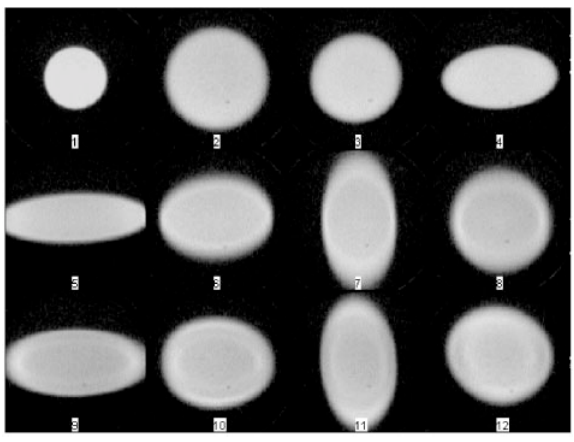
FIG. 3. Phosphor screen pictures from a CCD camera: (1) near aperture (6.3 mm diameter), near midplane of solenoid (2) and quadrupoles 1, 2, 3, 4, and 5 [(3), (5), (7), (9), and (11)]. The rest of the pictures are at planes between quads as